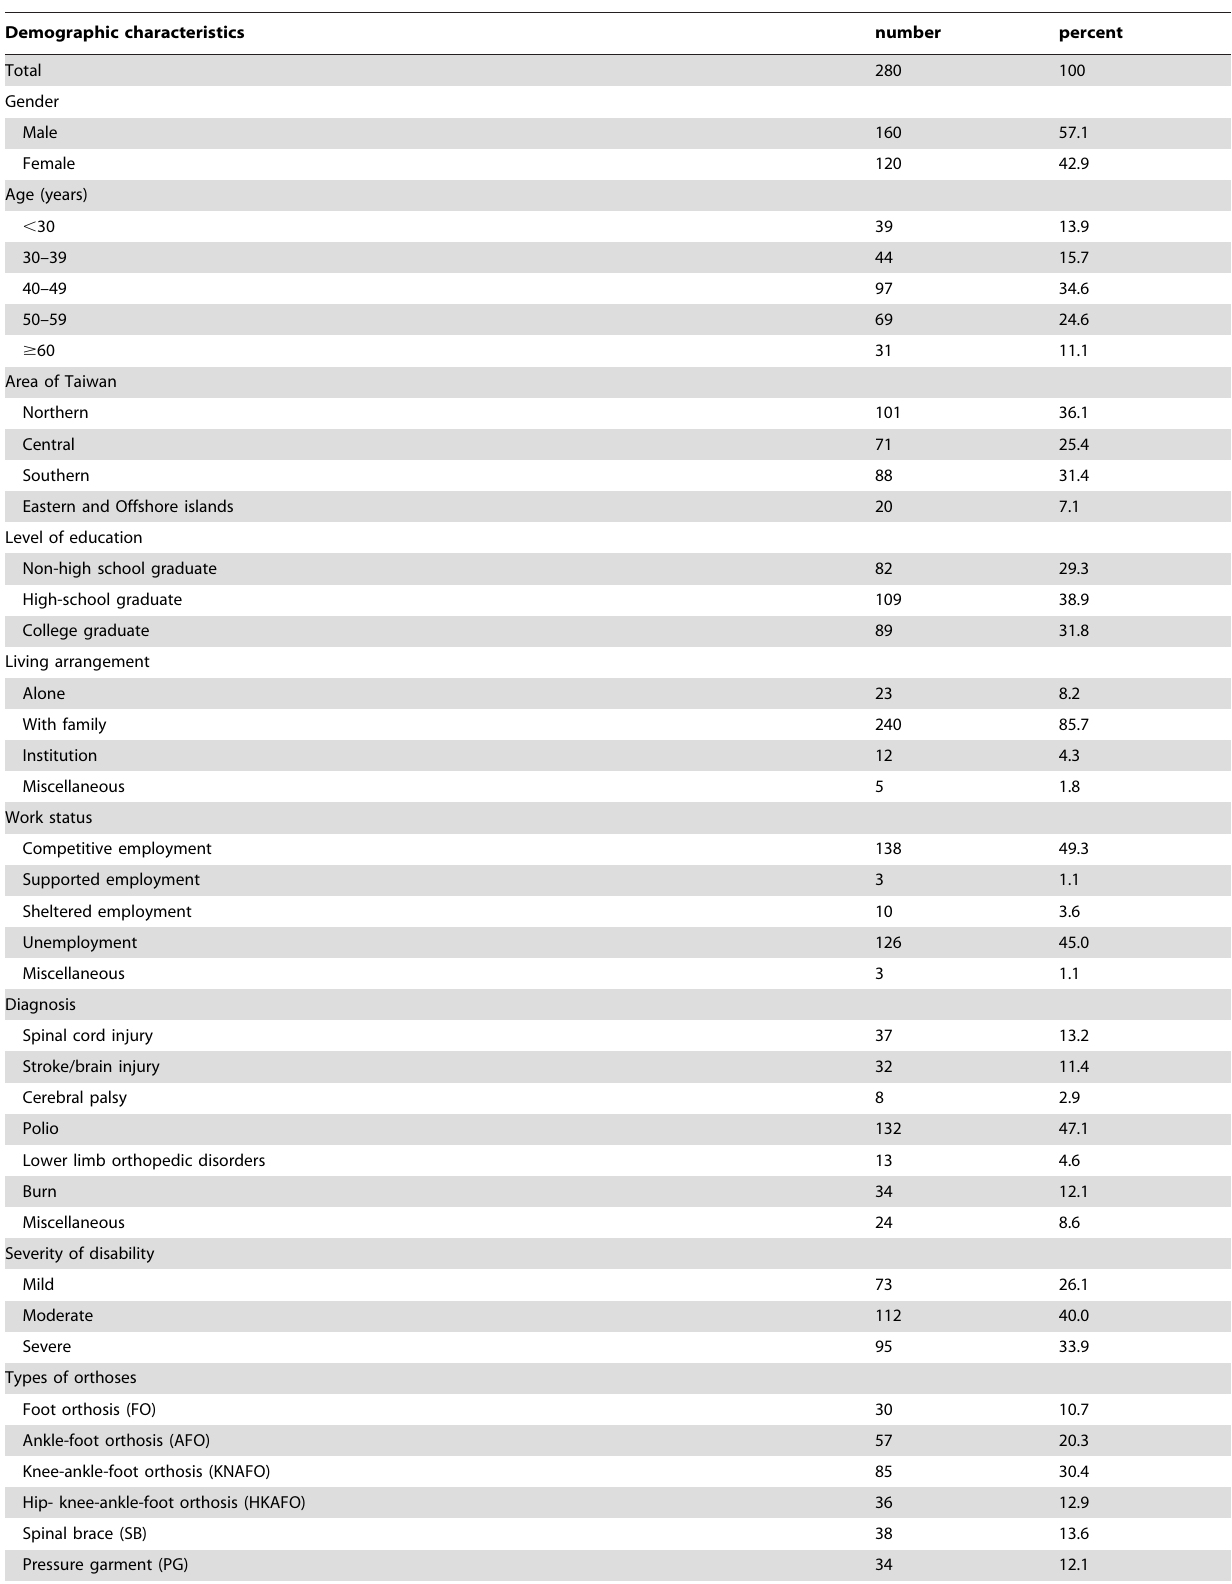
Table 1. Demographic and clinical characteristics of the